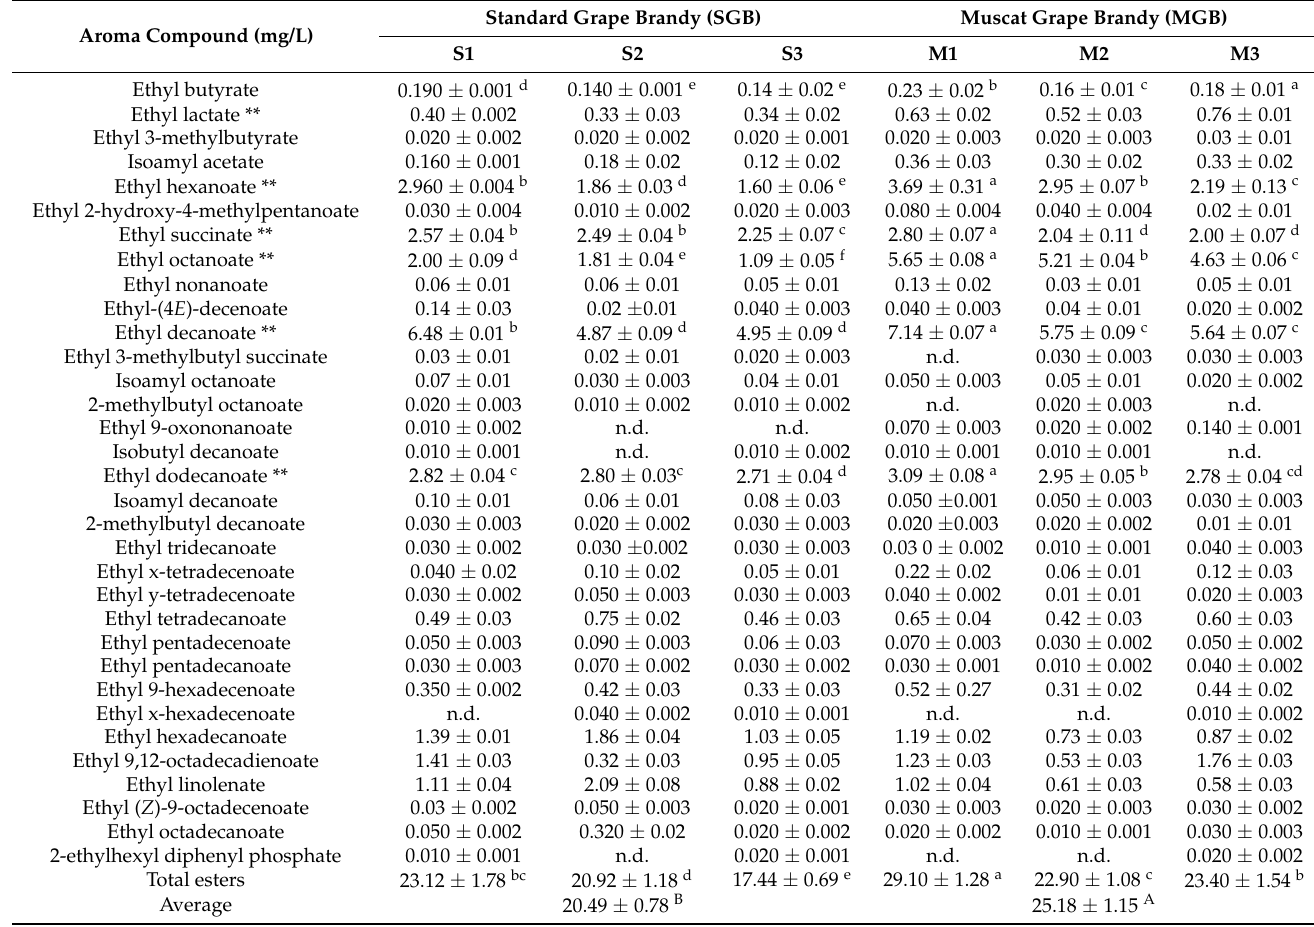
Table 2. Concentration of esters in standard and Muscat grape brandies in mg/L